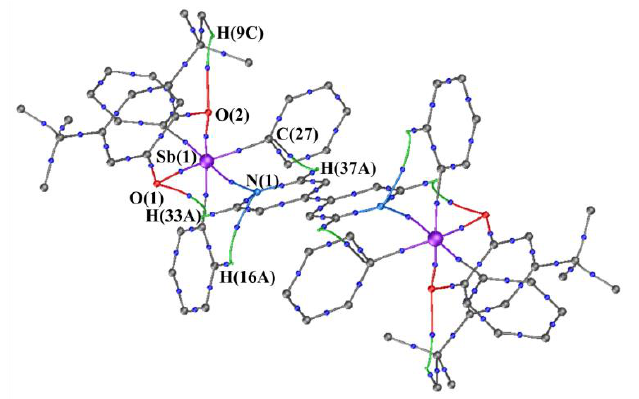
Figure 11. Experimental molecular graph of the complex 5 ED . The hydrogen atoms, except those participating in intramolecular interaction, are omitted for clarity. Only critical points (3, – 1) (blue color) are presented for clarity.